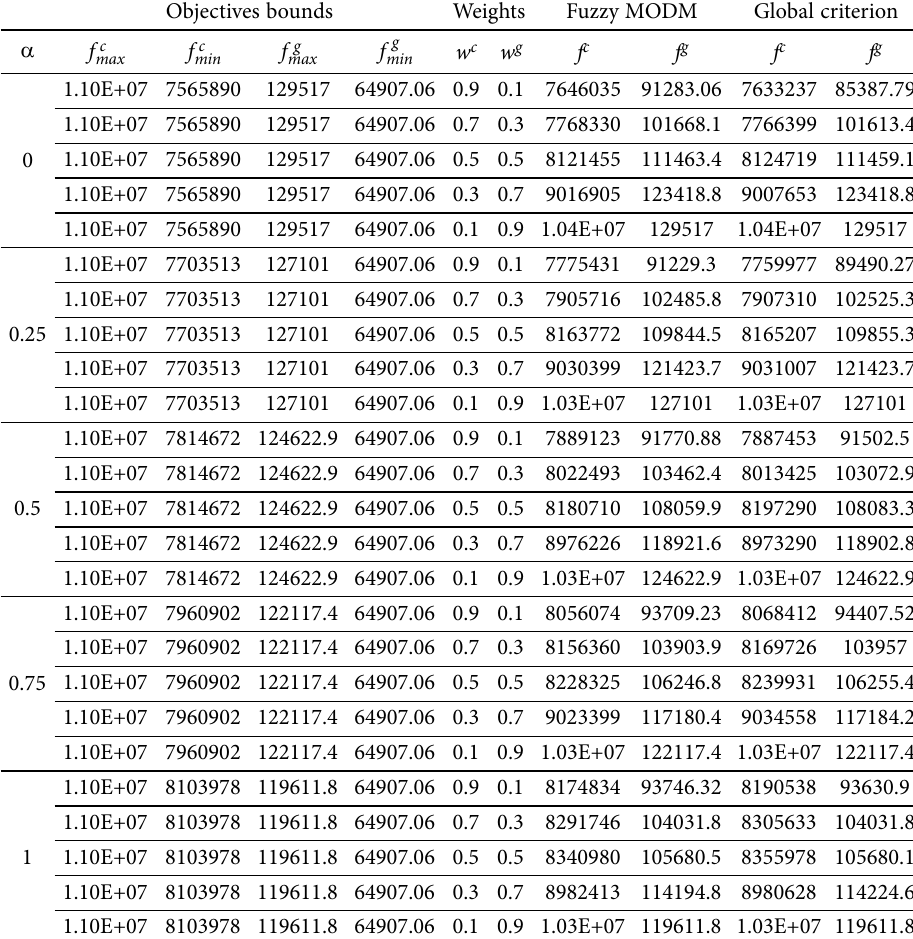
Table 7. The results of model in different a -cuts and different